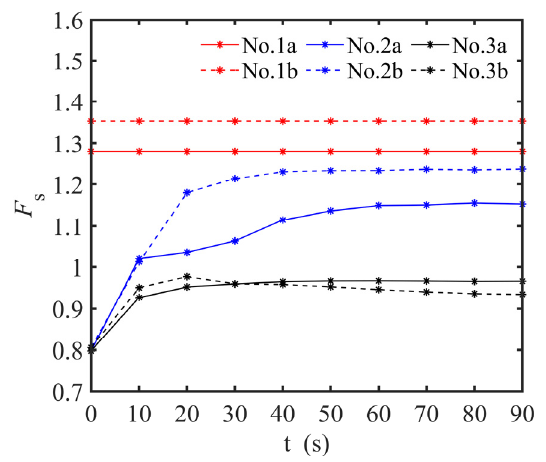
Figure 11. Safety factor for the local stability against time.